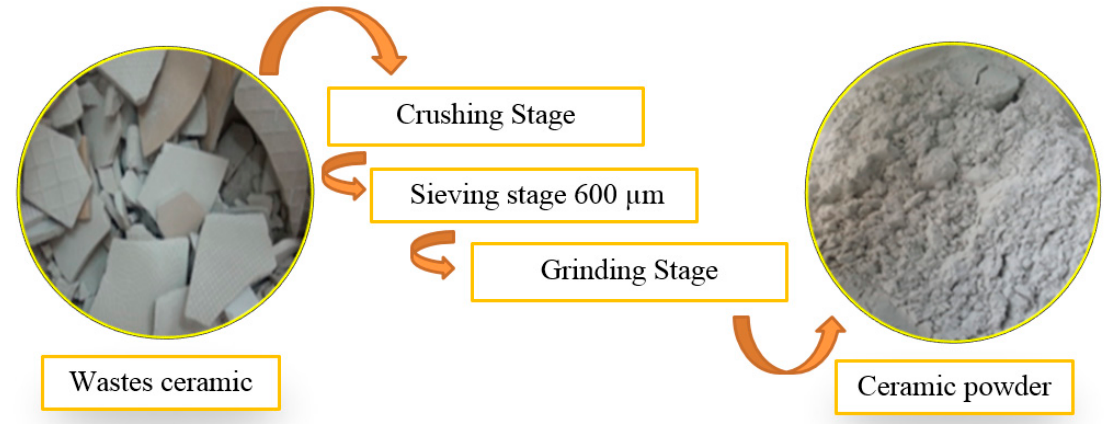
Figure 11. Cradle-to-gate process to produce ceramic powder from waste ceramics.